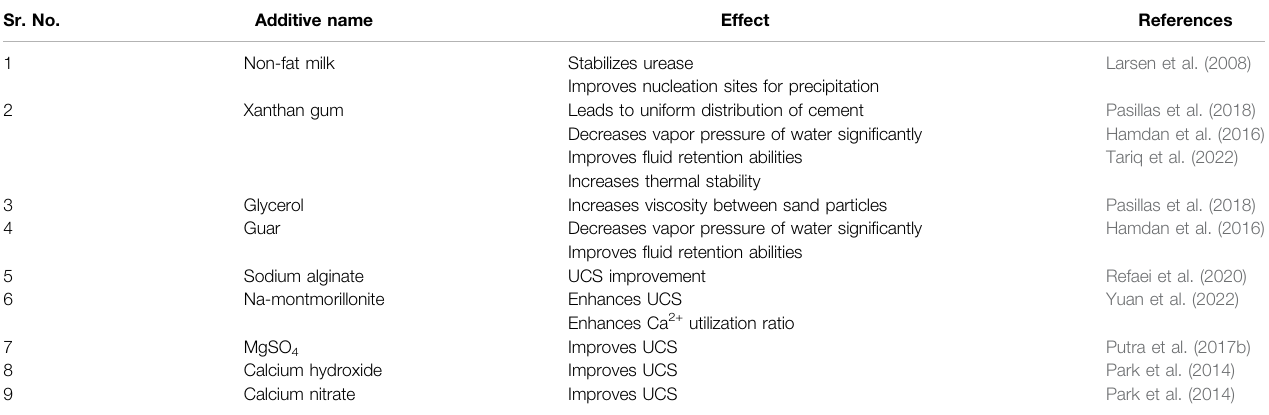
TABLE 2 | Effect of different EICP additives. Sr.